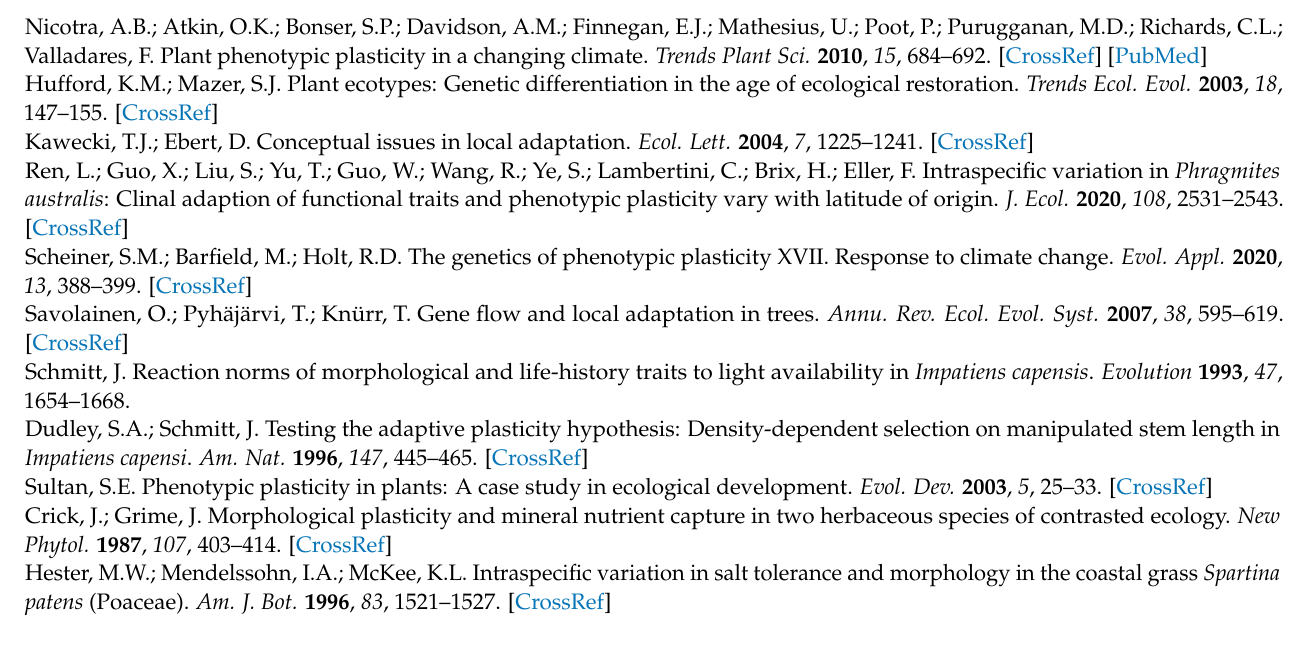
climatic data. Figure S1: Map of Saudi Arabia showing sampled regions of Aeluropus lagopoides populations; Figure S2: Pairwise geographical distance between the studied regions; Figure S3. Pearson’s Correlation heatmap between the top, middle, and bottom layer soil parameters and the different morphological and reproductive traits of Aeluropus lagopoides within different saline flat